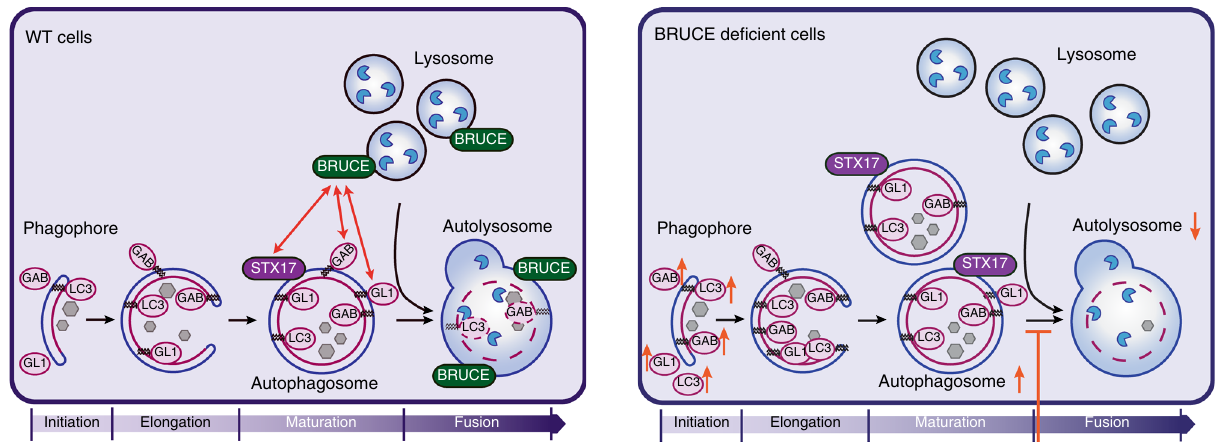
Fig. 8 BRUCE regulates autophagy fl ux by promoting autophagosome-lysosome fusion. Schematic illustrating the functional role of BRUCE during autophagy induction in wild type cells (left panel) and in BRUCE de fi cient cells (right panel). BRUCE interacts with GABARAP, GABARAPL1, and STX17, and localizes at the lysosomal as well as autolysosomal membranes (left panel). BRUCE-de fi cient cells have reduced numbers of autolysosomes and display an accumulation of LC3B, GABARAP, and GABARAPL1 due to inef fi cient autophagosome-lysosome fusion (right panel). LC3 (LC3B), GAB (GABARAP), GL1 (GABARAPL1), STX17 (Syntaxin Data presentation . Representative western blots are shown from three indepen- dent experiments in Figs. 1d, e, 2d, 3a, b, 6a and 7a, e, S3b, S3d-f, S4a-h, S4o, S6c, S7a-f and S7i; from two independent experiments in Figs. 2f and 3c, S3g-h, S4i-l, S4n, S6d and S7g – h. Representative confocal microscopy images are displayed from three independent experiments in Figs. 2b, 5a, 6b, 7b and d, S1e, S5a and S6a; from two independent experiments in Figs. 4a and 5d and S6b; from one experiment in Fig. 6c. Representative electron microscopy images in Fig. 5c are taken from two independent experiments. Representative replicate#1 from the shRNA screen is shown in Fig. 1b and Fig. S2b. Corresponding correlation plots for both replicates are displayed in Fig. S2c. Representative FACS plots from two independent experiments from Fig. S1b – c are shown in Fig. S1d. Odyssey-based quanti fi cation of Fig. S3c was taken from one experiment using identical samples as in Fig. 7a. Speci fi c data sets from RNA-Seq experiment are displayed in Fig. S3i and S5d. All assays used in this study were pre-established, and planned accordingly or variance was determined from pilot studies. Statistical method was not used to determine the power analysis. No samples were excluded from the analysis, and no speci fi c statistical method was used for randomization. Mean-variance relationship is estimated empirically. For quanti fi cation of microscopy data, the investigator was not blinded.